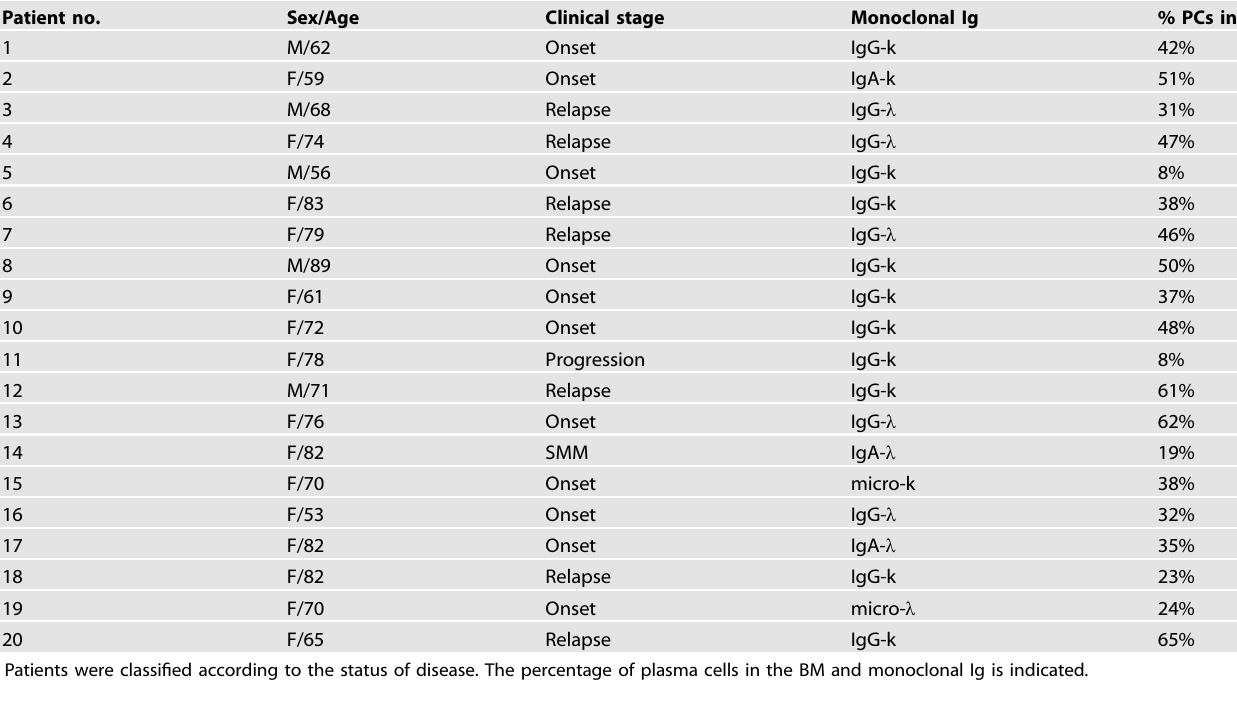
Table 1. Clinical parameters of MM patients.